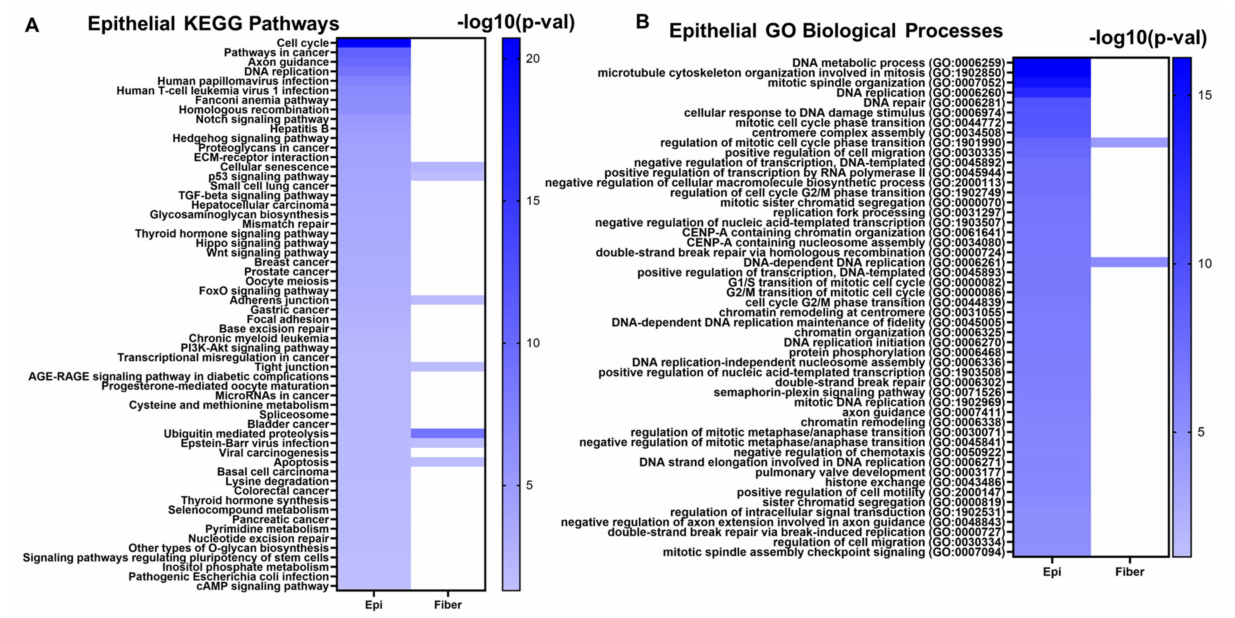
Figure 7. The top enriched KEGG (Kyoto Encyclopedia of Genes and Genomes) pathways ( A ) and GO Biological processes ( B ) associated with the evolutionarily conserved epithelial cell genes. Darker colors in the heatmap represent smaller p -values. Pathways and GO Biological processes that are also associated with fiber cell genes are also indicated in the heatmap in the “Fiber” column.